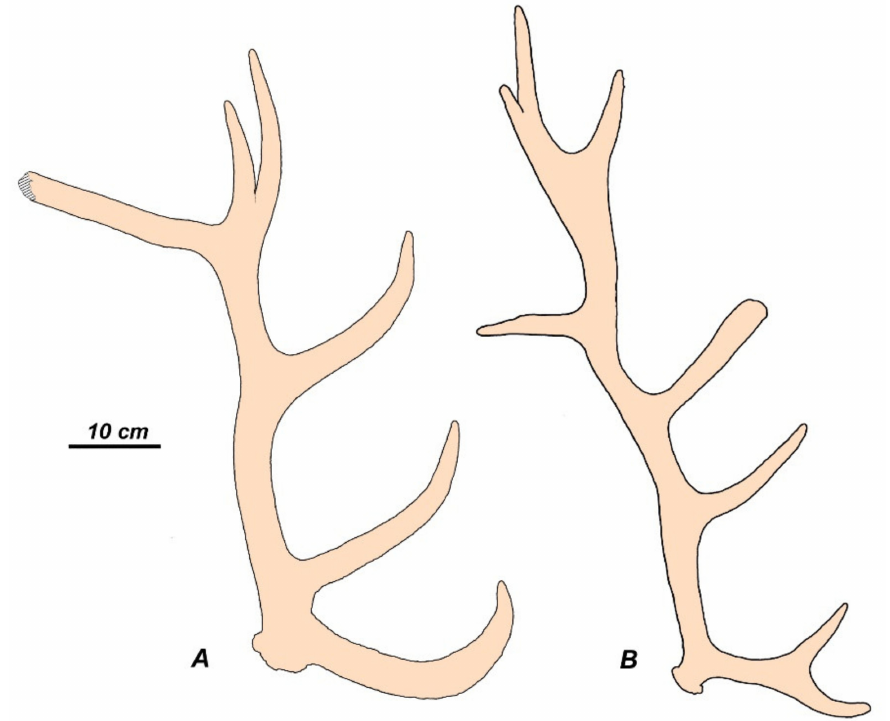
Figure 9. Example of convergent evolution of antlers of Pleistocene deer from western Europe (subfamily Cervinae) and South America (subfamily Capreolinae): ( A ), Cervus elaphus angulatus from Steinheim, Germany (Nr. 16201, State Museum of Natural History, Stuttgart); ( B ), Morenelaphus brachyceros from the Pleistocene of Tapalquen, Argentina (adapted from Carette